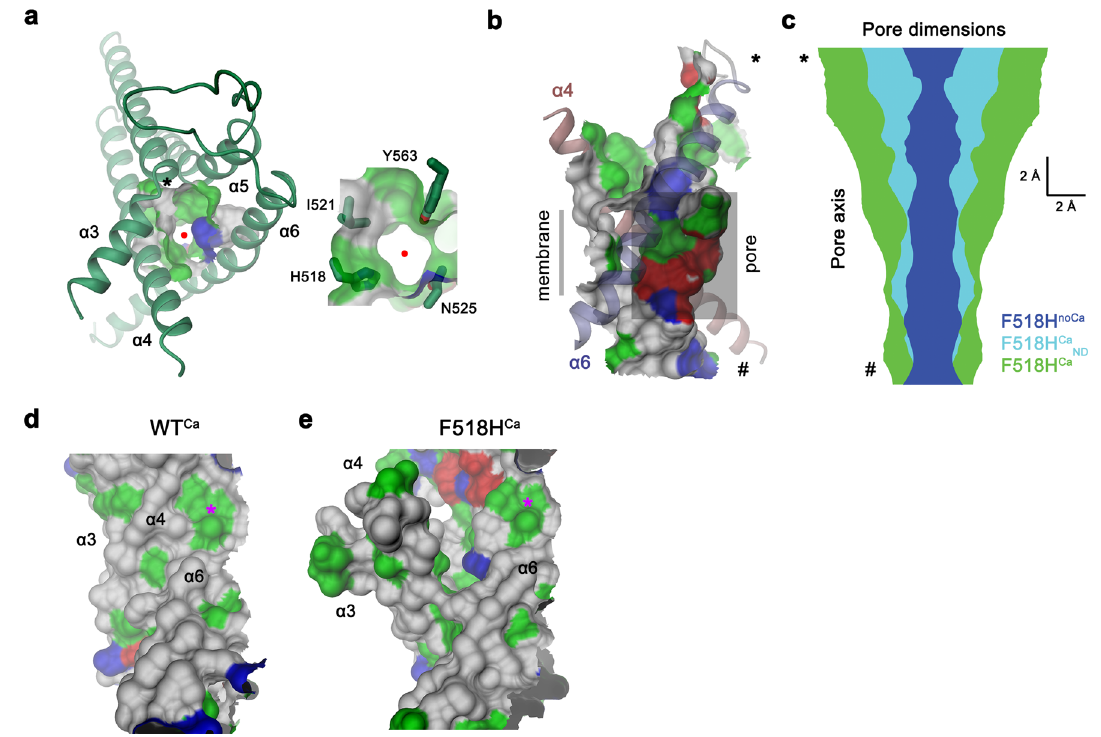
Fig.5|Ionandlipidconductionregion.a Poreregionobservedinthestructureof F518H Ca .Theviewisfromtheoutside.Insetdepictsblow-upofthesameregionwith sidechains of selected pore-lining residues shown as sticks. Red circle marks pore center, asterisk, the position of Gly 473. b Channel viewed from within the mem- brane. The protein-enclosed aqueous pore and the molecular surface facing the lipid blayer of the same region are indicated. c Pore diameter estimated by Hole 65 mapped along the pore axis from the outside (top) to the inside (bottom) for